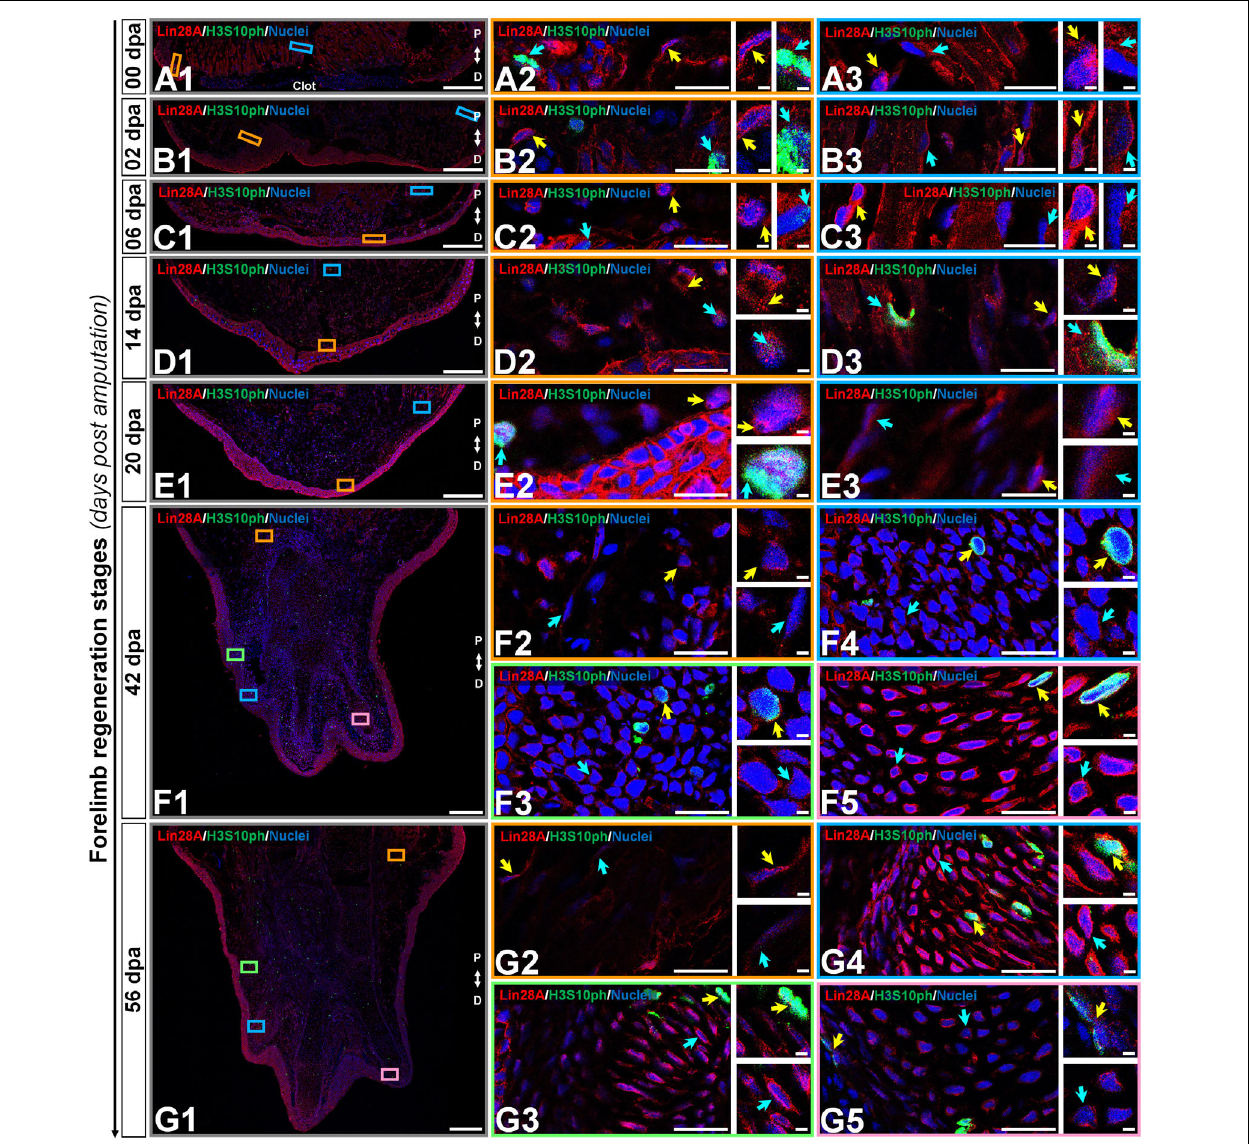
FIGURE 5 | Subcellular immunolocalization of amxLin28A during forelimb regeneration. (A–G) Histological sections of key stages during limb epimorphosis arranged in the Proximal-Distal axis. (A) Uninjured limb (00 dpa). (B) Wound healing stage (02 dpa). (C) Apical epidermal cap stage (06 dpa). (D) Early blastema stage (14 dpa). (E) Medium blastema stage (20 dpa). (F) Late palette–early digits stage (42 dpa). (G) Late digits–growth stage (56 dpa). (A1–G1) Intracellular detection of amxLin28A marked in red, and H3S10ph in green for mitotic cells, by contrast with DAPI (blue) to delimit nuclei. Scale bars: 500 µ m. (A2/3–G2/3/4/5) Ampliations with distinct color contours to distinguish some areas of interest for amxLin28A in red, H3S10ph in green, and DAPI in blue; yellow and cyan arrows have in turn their own magnifications. Scale bars: 50 and 5 µ m, respectively. The different arrows mark diverse tissue components, as described in results.